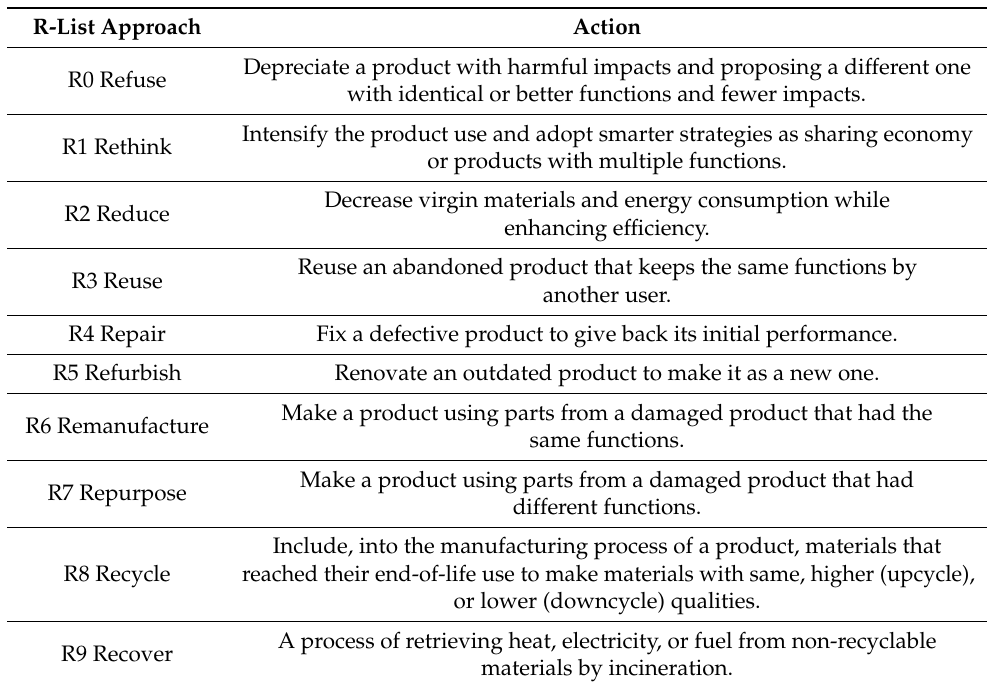
Table 1. R-list strategies to ensure a shift towards a Circular Economy (CE) (adapted from